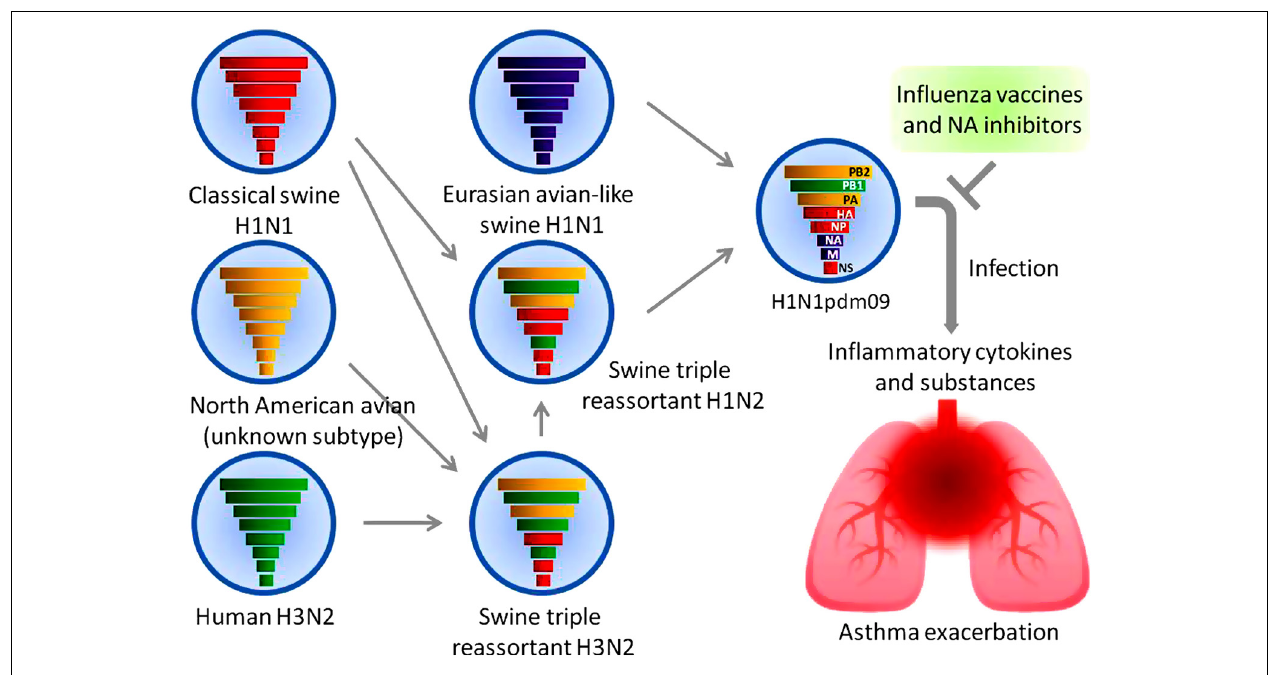
FIGURE 1 |A(H1N1)pdm09 virus and asthma. The reassortment of a triple reassortant swine A(H1N2) virus with a Eurasian avian-like swine A(H1N1) virus resulted in the pandemic A(H1N1) 2009 virus.The colored solid rods represent the gene segments as follows. Classical swine A(H1N1) virus: red.